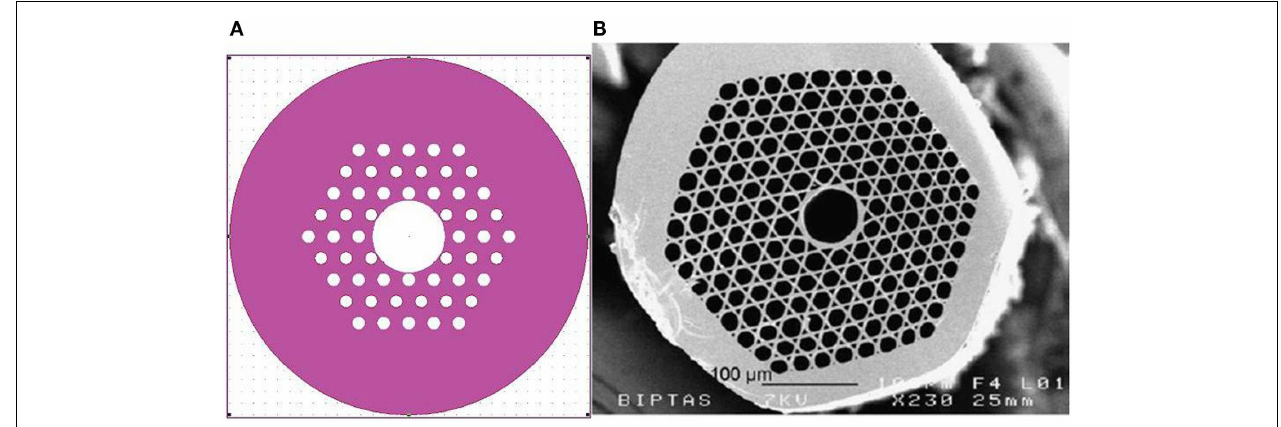
FIGURE 2 | (A) Geometry for 2-D PCFs; (B) Te 20 As 30 Se 50 hollow-core PCF profiles with Kagome lattice cladding (Desevedavy et al., 2010).